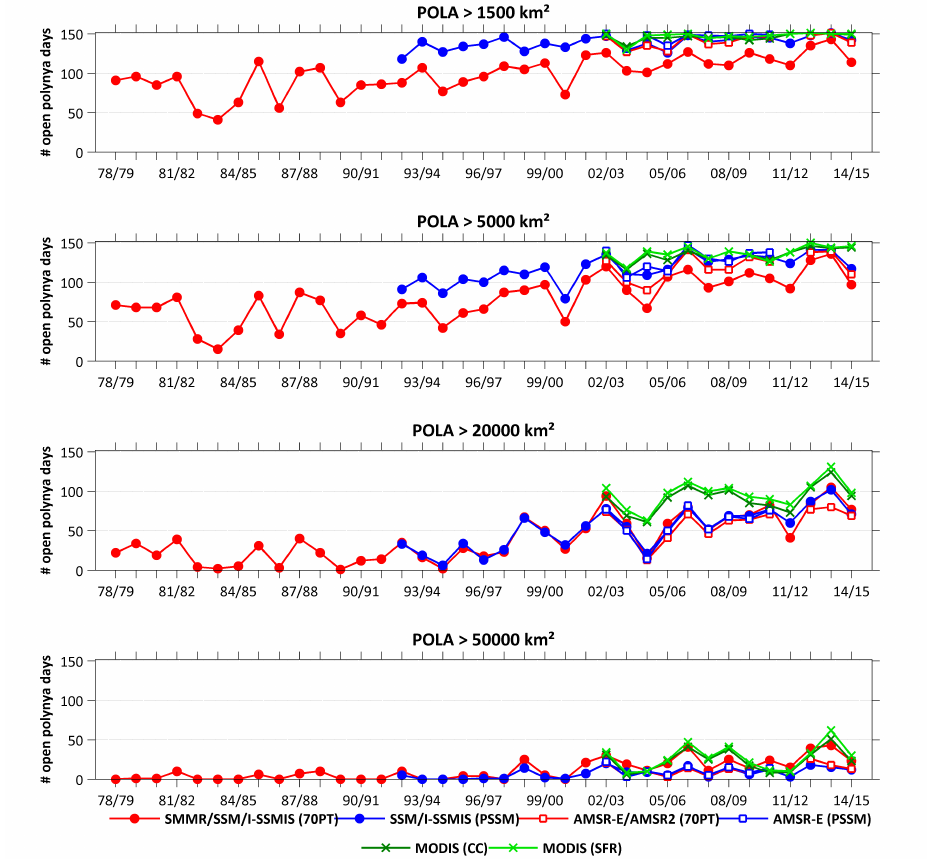
Figure 6. Number of polynya days with an area of ě 1500 km 2 , ě 5000 km 2 , ě 20,000 km 2 and ě 50,000 km 2 within the applied polynya mask. A comparison is made between POLA estimations based on daily MODIS TIT composites (CC: dark green crosses; SFR: light green crosses) and passive microwave sensors (SMMR/SSM/I-SSMIS 70PT: filled red circles; AMSR-E/AMSR2 70PT: unfilled red squares; SSM/I-SSMIS PSSM: filled blue circles; AMSR-E PSSM: unfilled blue squares). The numbers indicate the amount of polynya days for each area threshold from